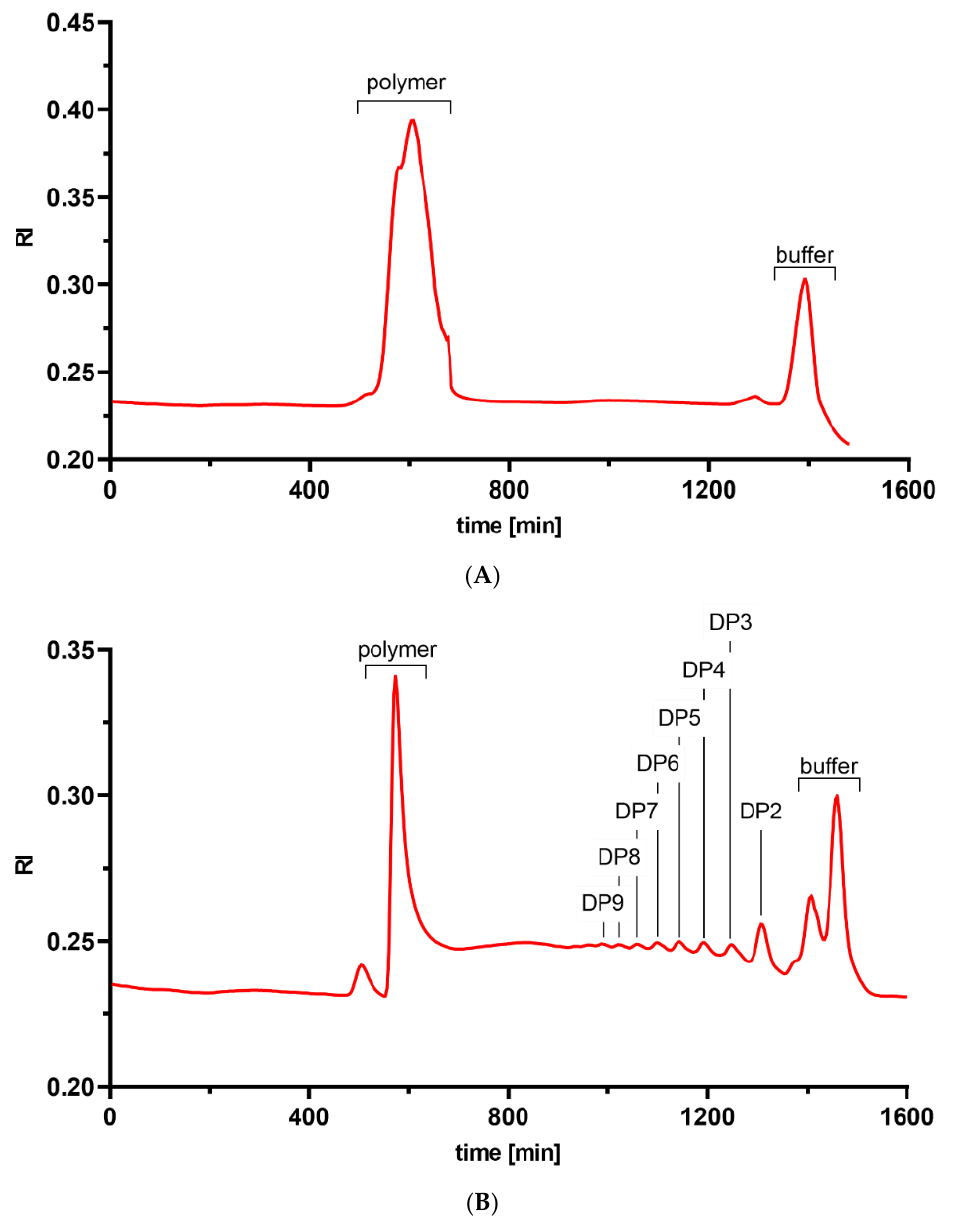
Figure 1. HP-SEC-RI-MALLS chromatograms of the parental chitosan ( A ) and the chitosan hydrol- ysate ( B ). The cut-off for separation of the polymer and oligomer fractions of the chitosan hydroly- sate was made at 800 min, which corresponds to a DP of ca. 15.